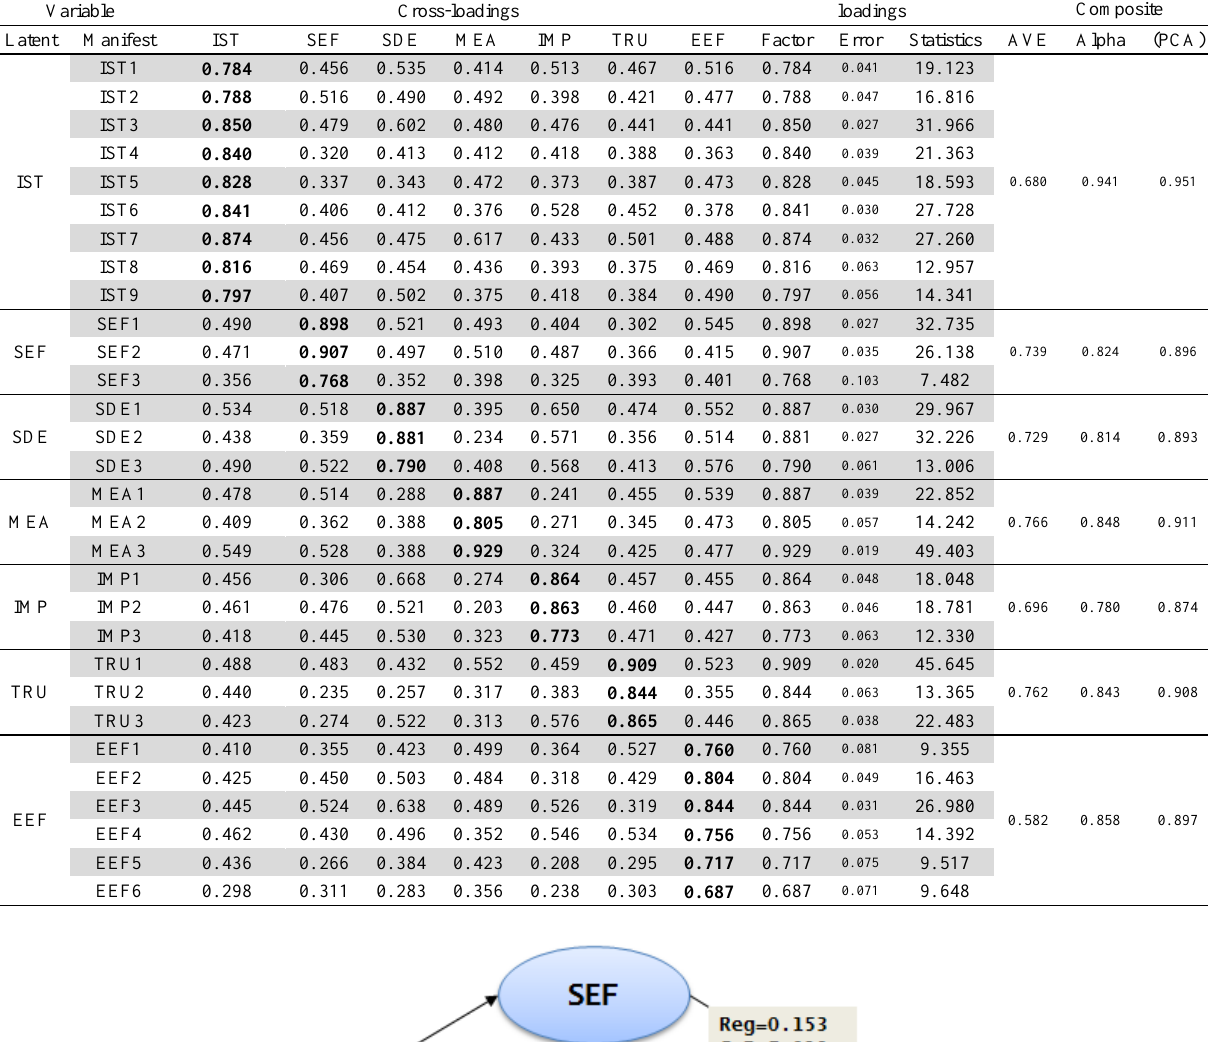
The summary of Cross-loadings and loadings components Variable